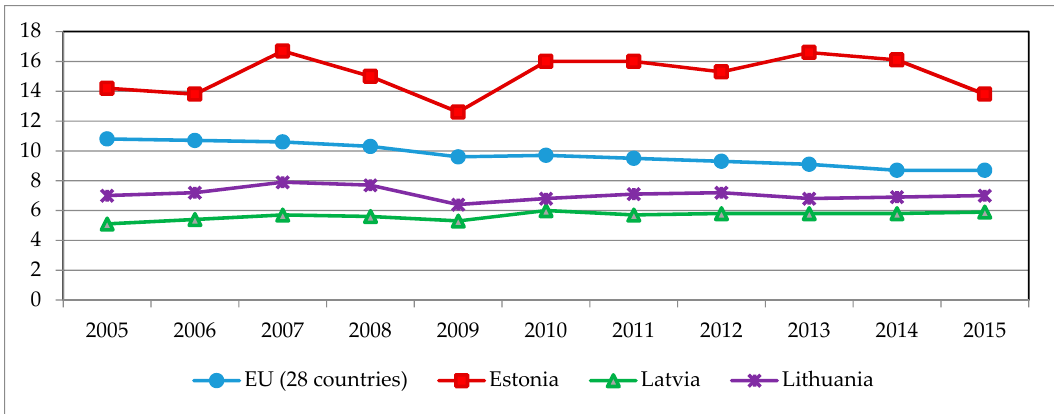
Figure 13. Greenhouse gas emissions per capita, tons of CO 2 equivalent.